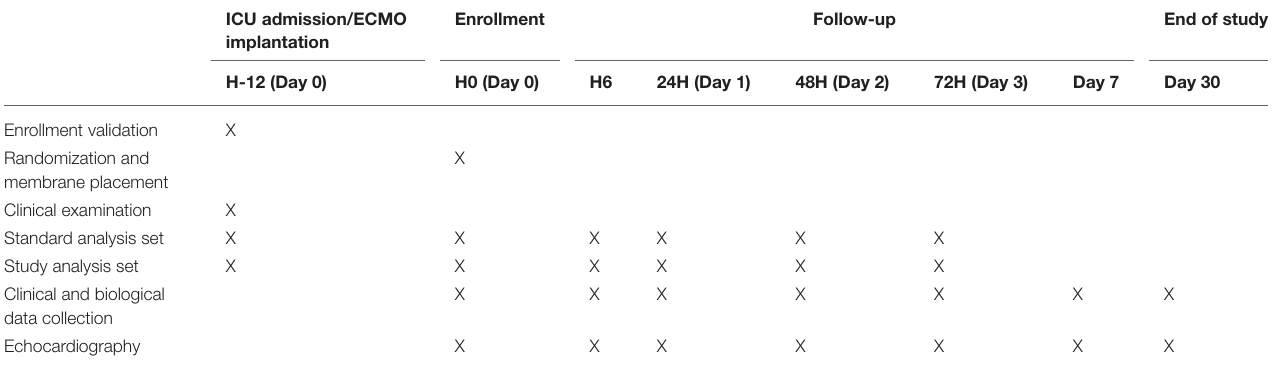
TABLE 1 | Protocol chronology of the study.